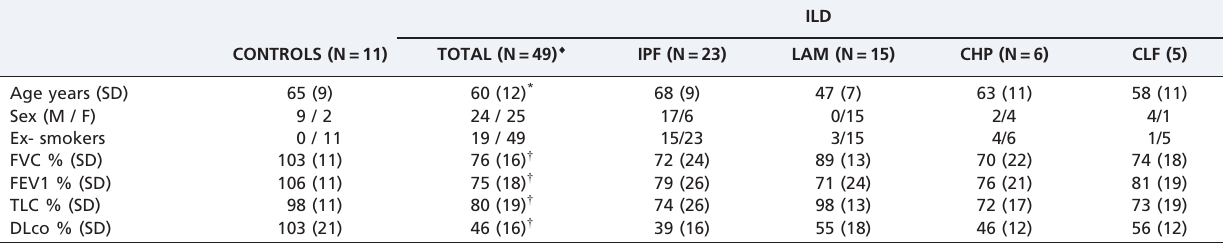
Table 1 - Demographic and functional parameters in ILD patients and